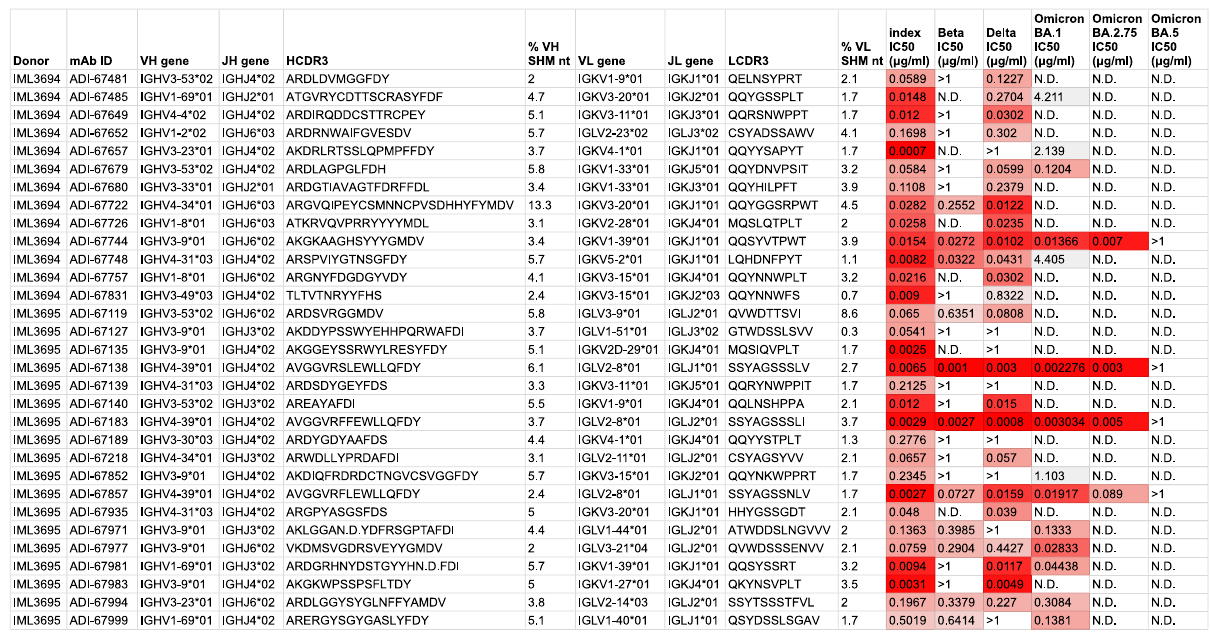
Fig. 2 | Properties of SARS-CoV-2 neutralizing mAbs. An IC 50 threshold of 0.4 μ g/ml against any of the SARS-CoV-2 variants quali fi ed mAbs as neutralizing. The table includes heavy and light chain VDJ assignments as well as SHM values and IC 50 s against 6 SARS-CoV-2